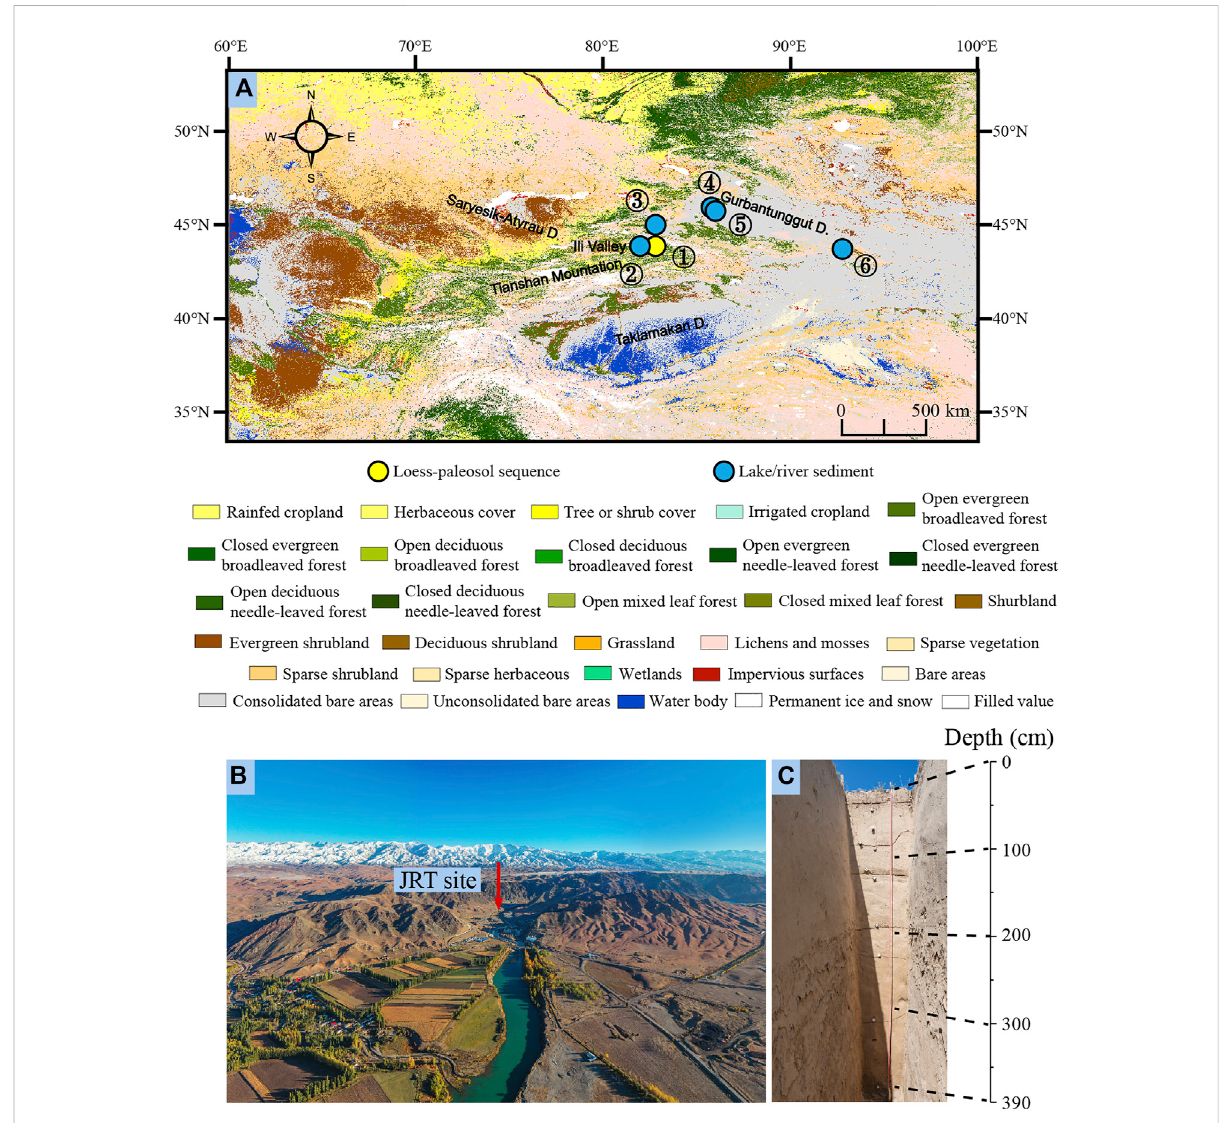
FIGURE 1 Land cover and geomorphology around the Ili Valley in ACA (The land cover data in panel (A) are derived from Liu and Zhang (2021)). (A) Location of the JRT section and other pollen records mentioned in this paper (1. JRT section, this study; 2. Yili section (Li et al., 2011); 3. Lake Abi; 4. Lake Ailike; 5. Lake Manas; 6. Lake Bilikun); (B) Environmental conditions surrounding the JRT section; (C) JRT section and OSL sampling